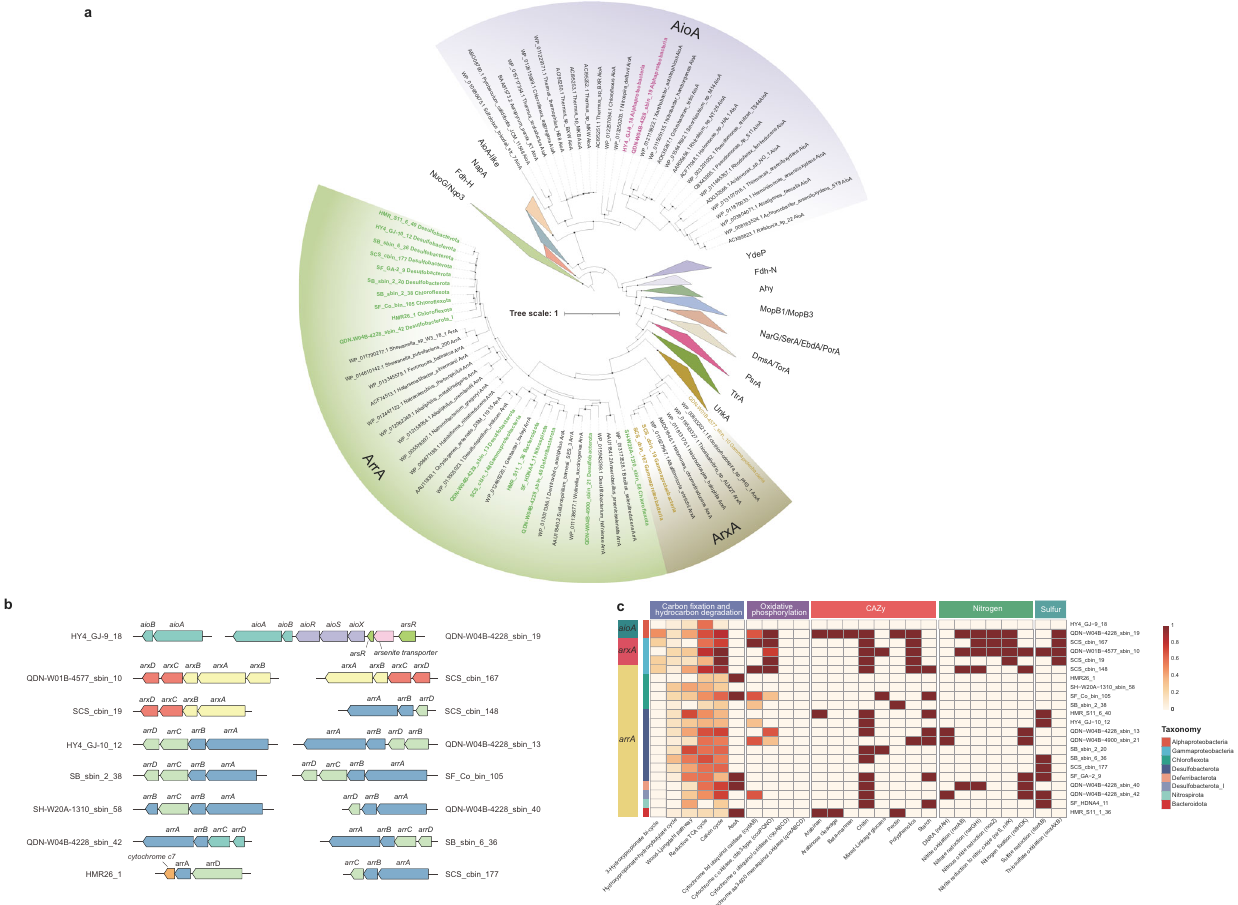
Fig. 5 The metabolic potential of the arsenotrophic gene-carrying MAGs. a A maximum-likelihood tree of the DMSO reductase family, with protein sequences identi fi ed as associated with arsenotrophic enzymes in this study. Bootstrap values are generated from 1000 replicates. Bootstrap values ≥ 70 are shown. Scale bar indicates amino acid substitutions per site. b The genomic context of the aioA , arxA and arrA genes in MAGs containing arsenotrophic genes. c Heatmap showing the predicted metabolism in potential As-respiring microbes. Detailed annotation is presented in Supplementary Data 6. The completeness of each pathway was calculated using the DRAM Distill